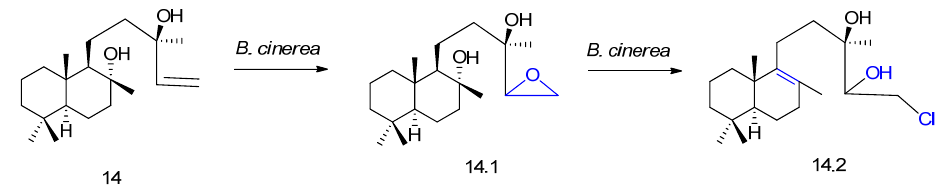
Figure 15. Epoxidation ( 14.1 ) and halogenation ( 14.2 ) of sclareol ( 14 ) by Botrytis cinerea [60] .